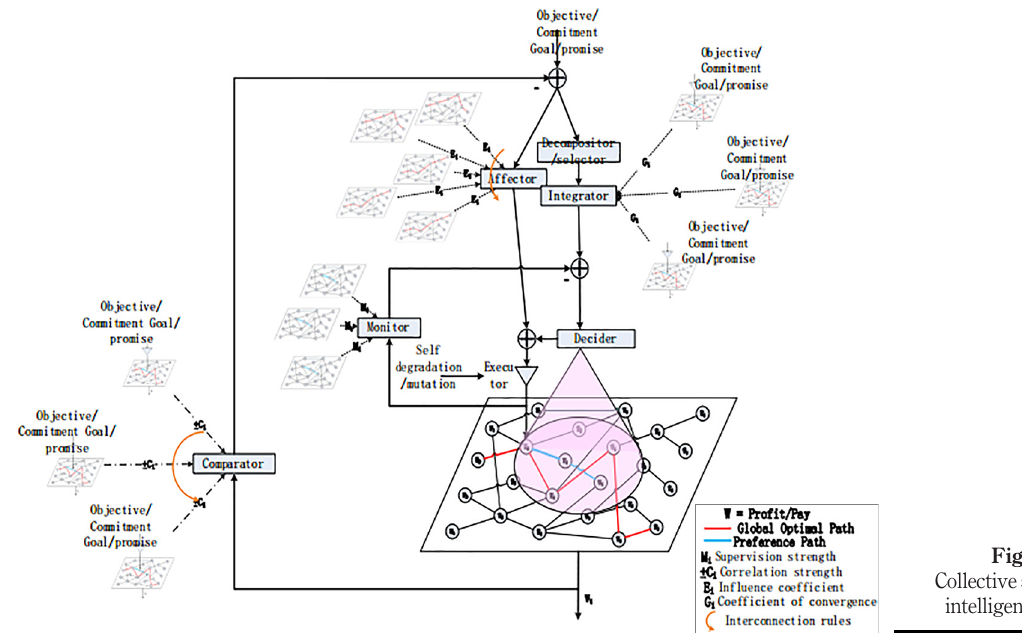
Figure 5. Collective swarm intelligence